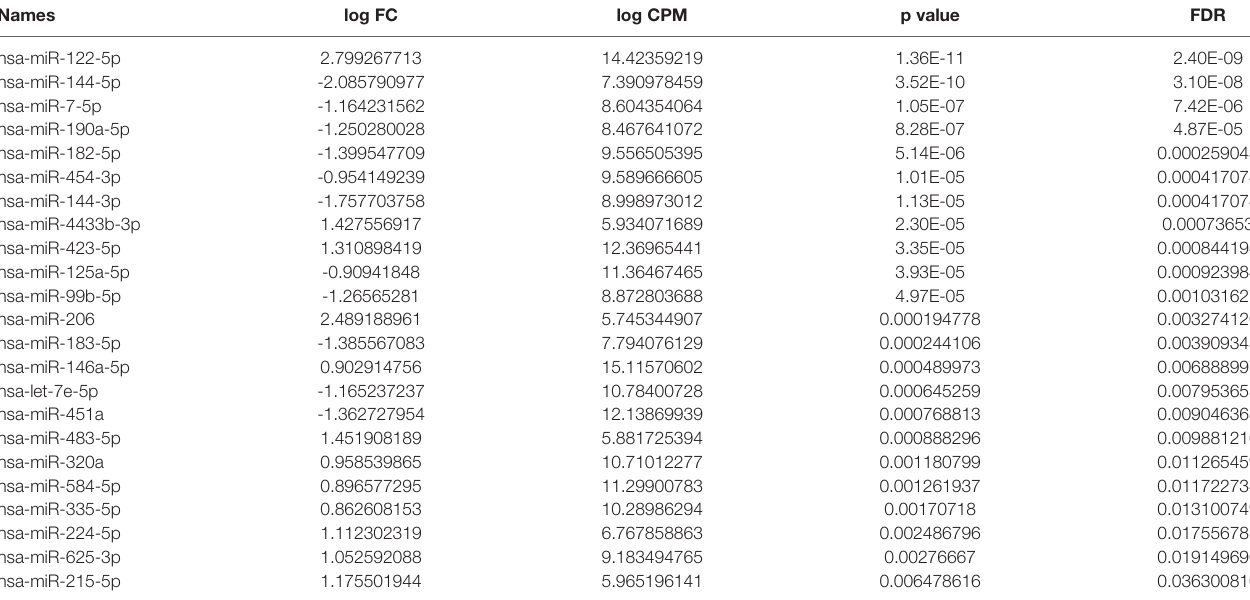
TABLE 2 | Differentially expressed miRNAs between CHB patients and controls in plasma. Names